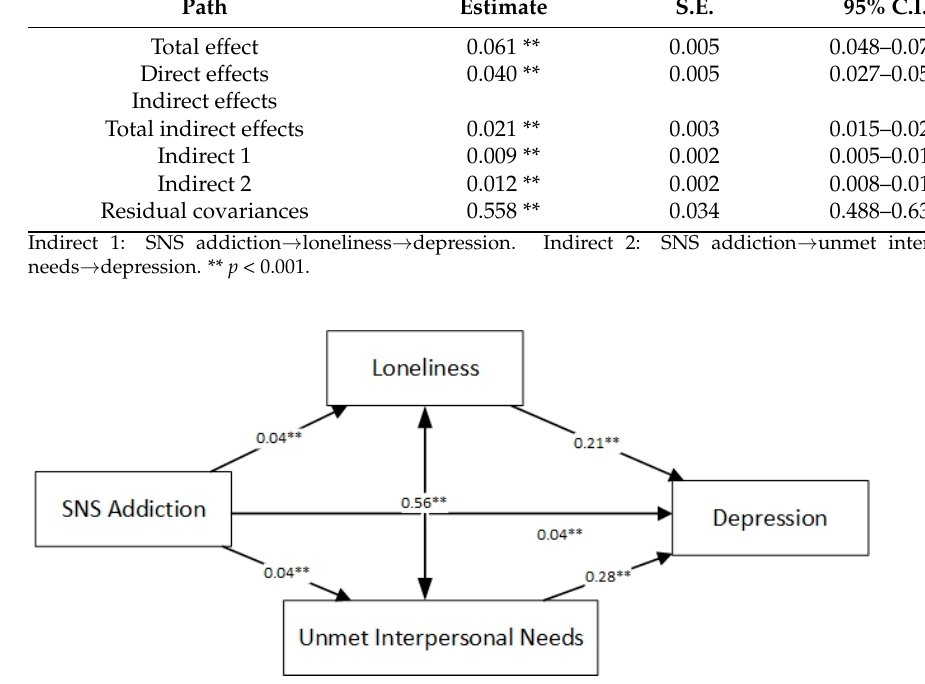
Figure 1. The serial multiple mediation of loneliness and unmet interpersonal needs between SNS addiction and depression. NOTE: Path coefficients were shown in standardized regression coefficients. ** p < 0.001.